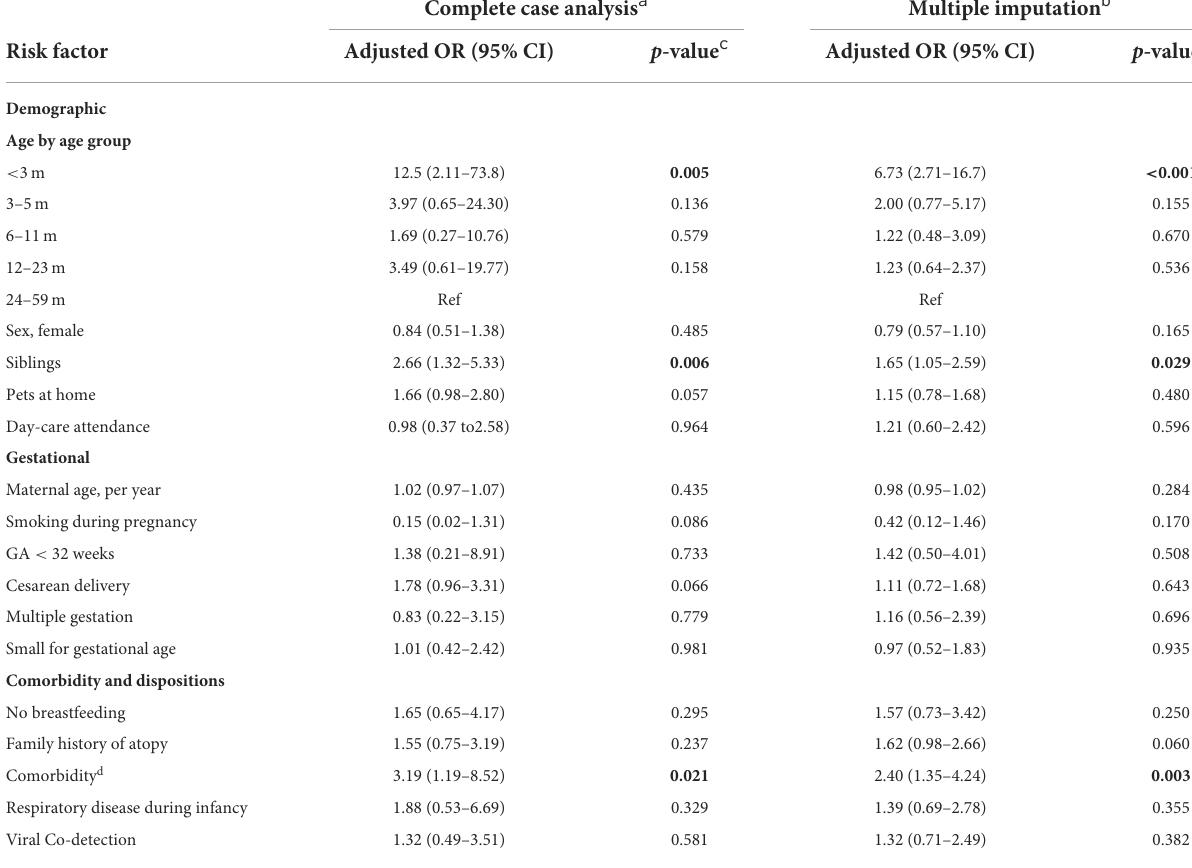
TABLE 2 Risk factors for need for respiratory support in RSV positive hospitalized children under 5 years of